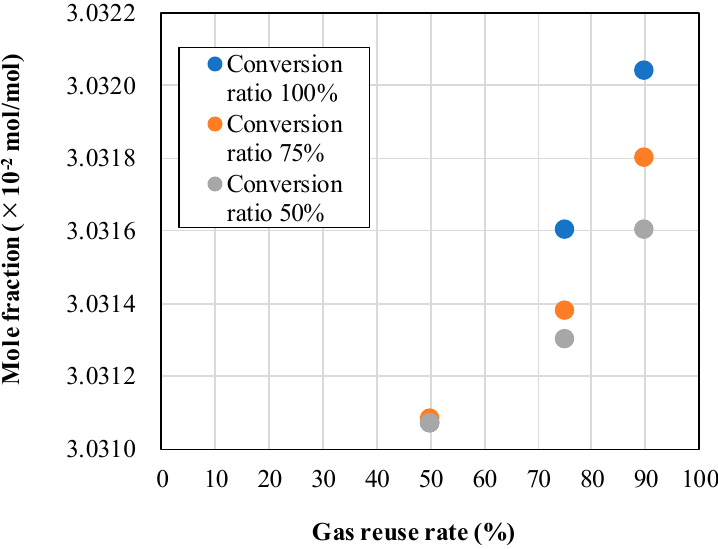
Figure 5. Simulation results of CH 4 concentration for each conversion ratio at “Fin”.